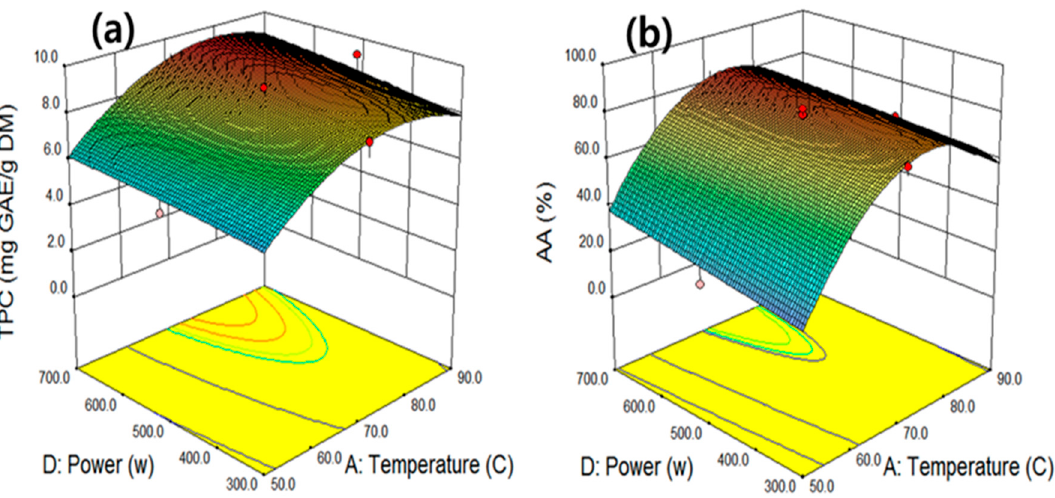
Figure 4. The interactive effect of temperature and ultrasonic power on total phenolic compounds ( a ) and antioxidant activity ( b ) at fixed levels of extraction time 45 min and ethanol concentration 58.3%.